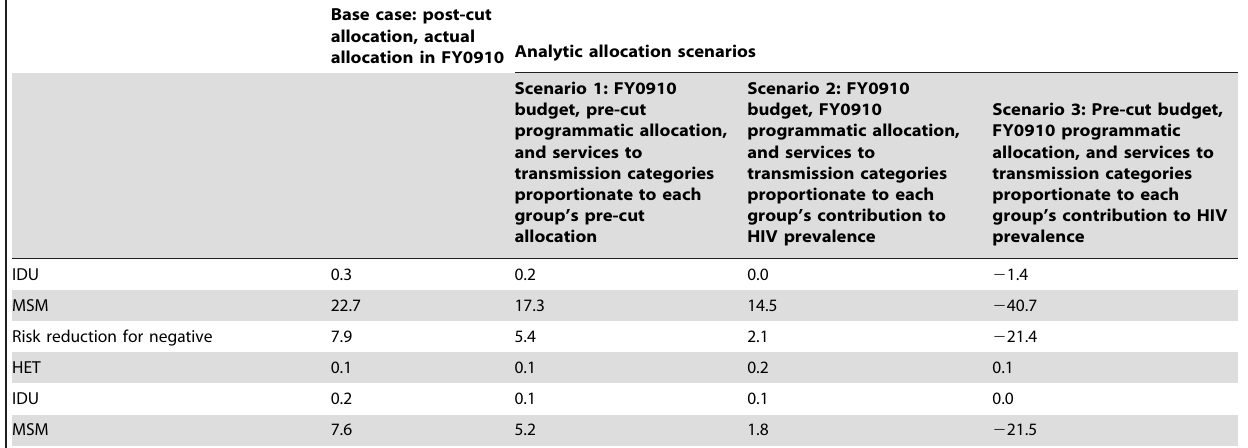
Base case: post-cut allocation, actual